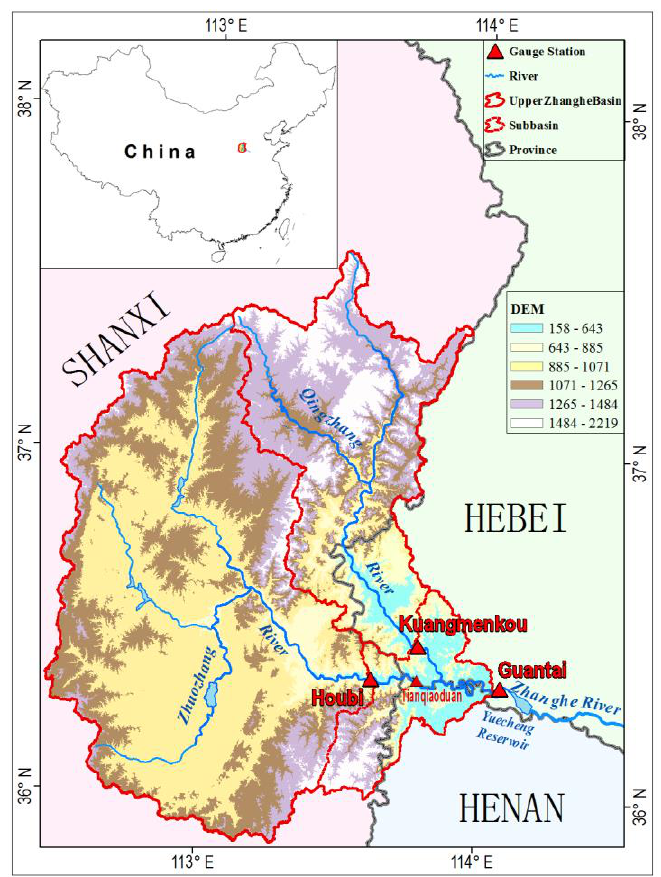
Figure 1. The Upper Zhanghe River Basin.